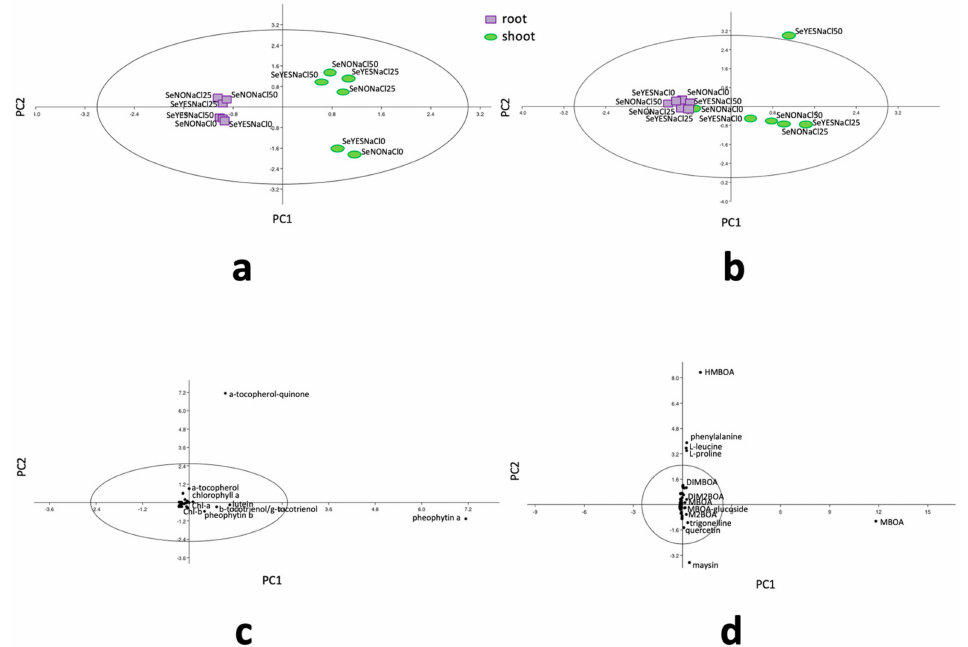
Figure 1. Principal component analysis of non-polar and semipolar metabolomes in terms of treatment ( a, b ) and metabolite ( c, d ) levels in maize sprouts obtained at 0, 25, or 50 mM NaCl (i.e., NaCl 0 , NaCl 25 , and NaCl 50 , respectively) from grains produced without or with Se fertilization (i.e., Se NO and Se YES , respectively) in comparison to the control Se NO NaCl 0